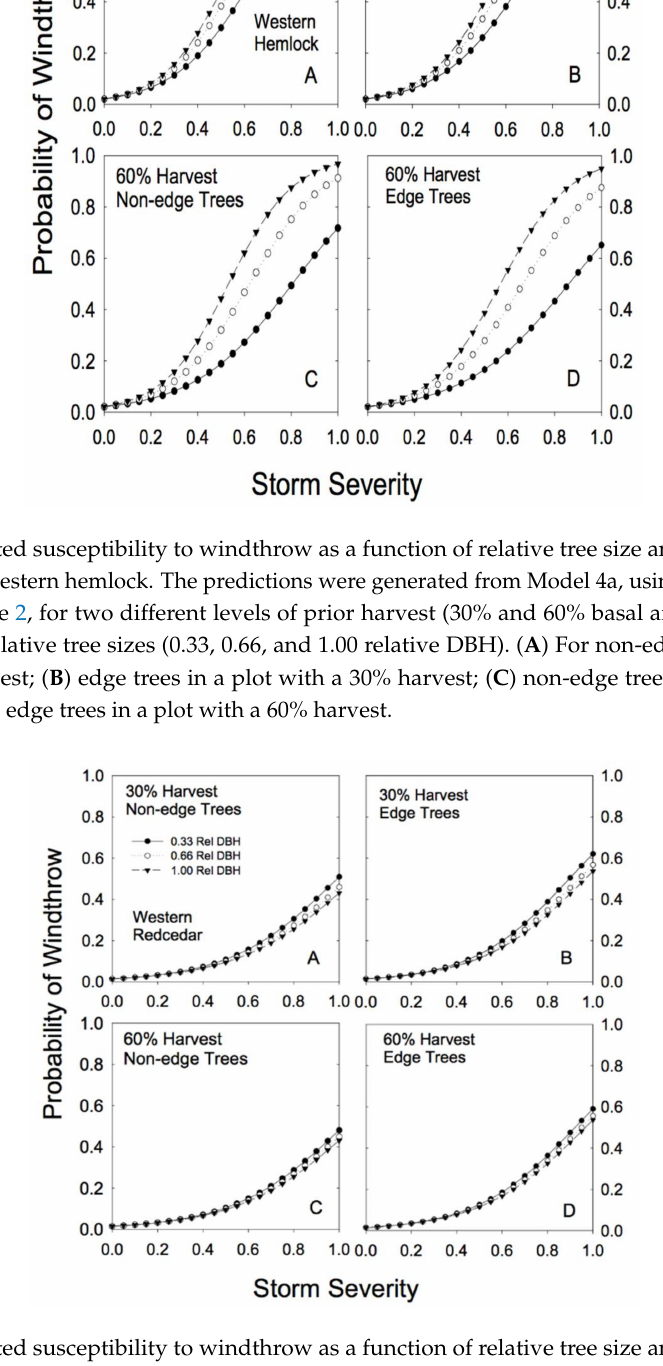
Figure 5. Predicted susceptibility to windthrow as a function of relative tree size and proximity to a forest edge for western redcedar. The predictions were generated from Model 4a, using the parameters reported in Table 2, for two different levels of prior harvest (30% and 60% basal area removal) and for 3 different relative tree sizes (0.33, 0.66, and 1.00 relative DBH). ( A ) For non-edge trees in a plot with a 30% harvest; ( B ) edge trees in a plot with a 30% harvest; ( C ) non-edge trees in a plot with a 60% harvest; ( D ) edge trees in a plot with a 60%